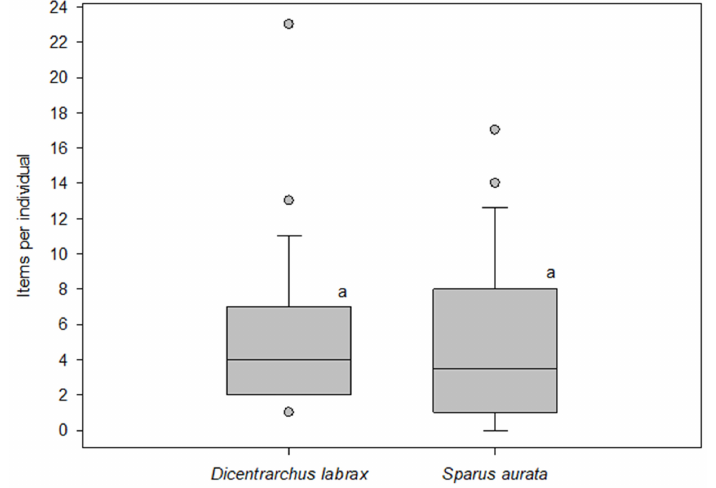
Figure 1. Number of anthropogenic particle items per individual in two aquaculture species of fish, Dicentrarchus labrax and Sparus aurata ; n = 42–45; boxes with the same letter indicate no significant differences ( p > 0.05). The boundary of the box closest to zero indicates the 25th percentile, a line within the box marks the median, and the boundary of the box farthest from zero indicates the 75th percentile. Whiskers (error bars) above and below the box indicate the 90th and 10th percentiles. Circles represent outliers.